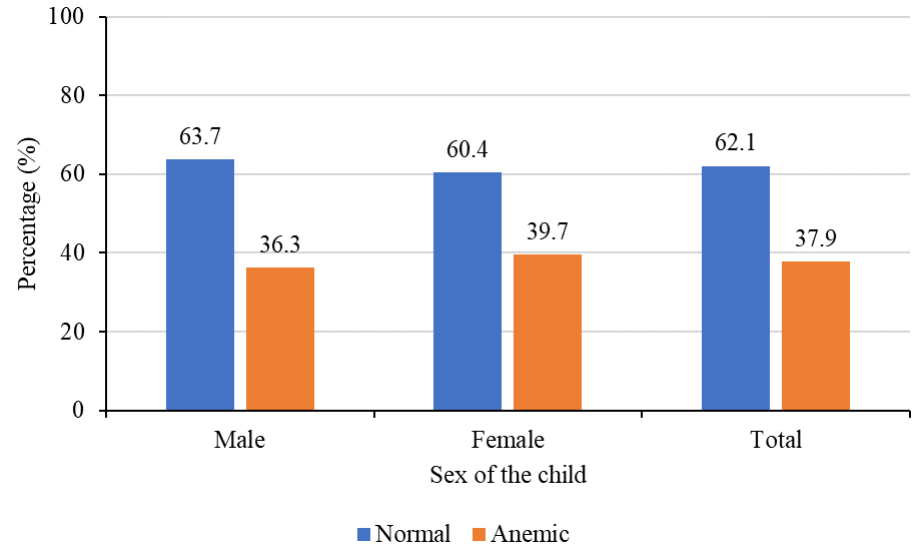
Figure 2. Prevalence of anemia by sex of the child (N=602).